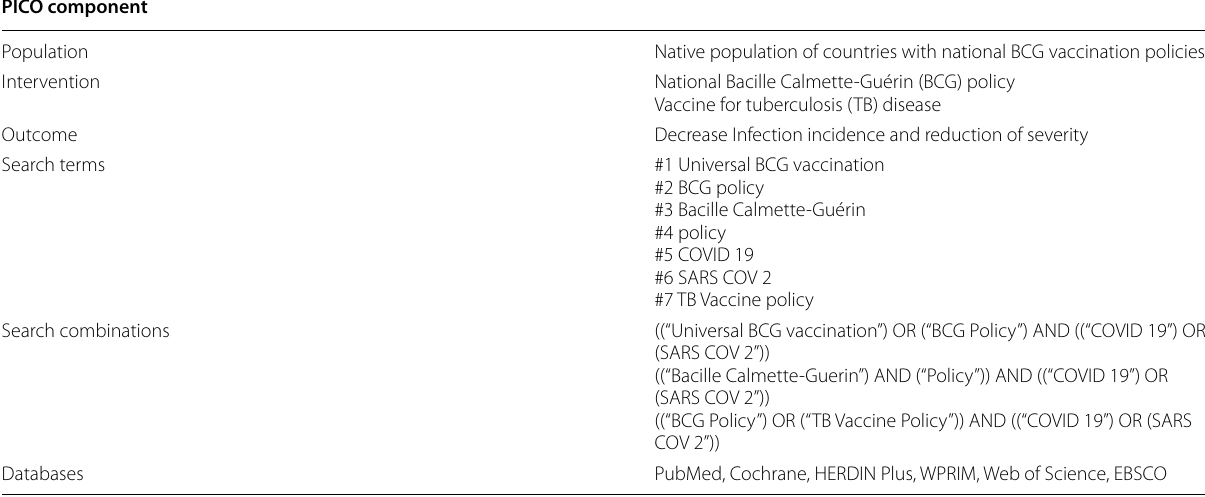
Table 1 Detailed search and selection strategy PICO